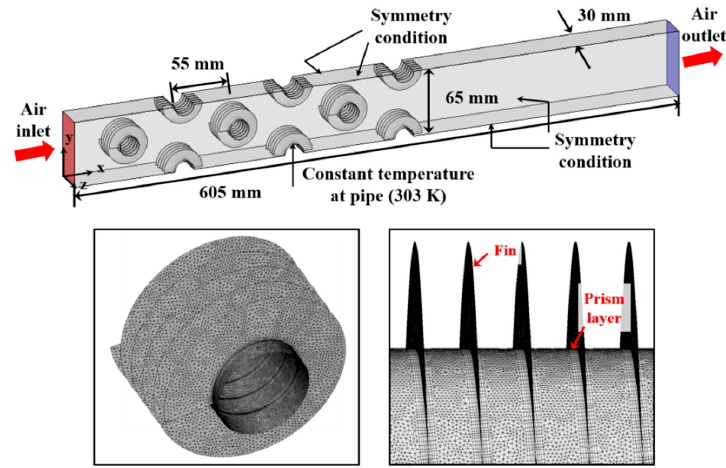
Figure 1. Computational domain and grid generation.